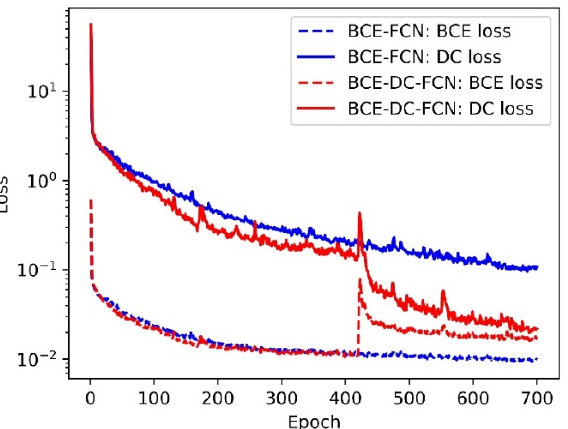
Figure 9. Tube contour detection results on several samples. The images in the left column were produced by an FCN model that took the LDR image as input, and in the right column were pro- duced by an FCN model that took ME images as input.